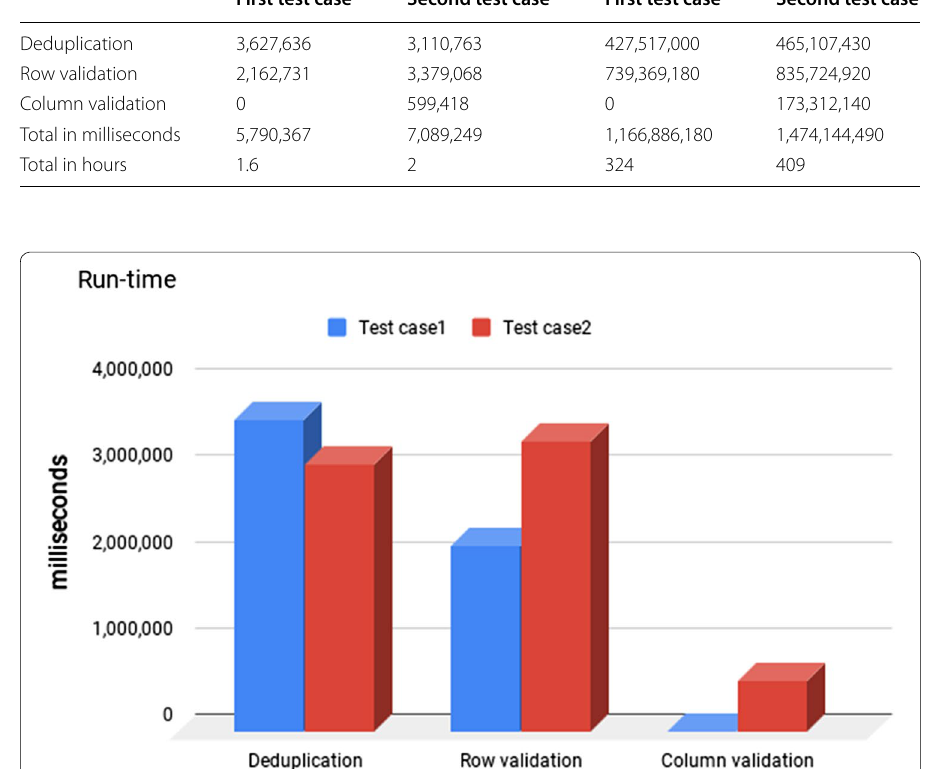
Fig. 16 Run-time chart for the two test cases. X-axis: Validation stage Y-axis: Run-time in